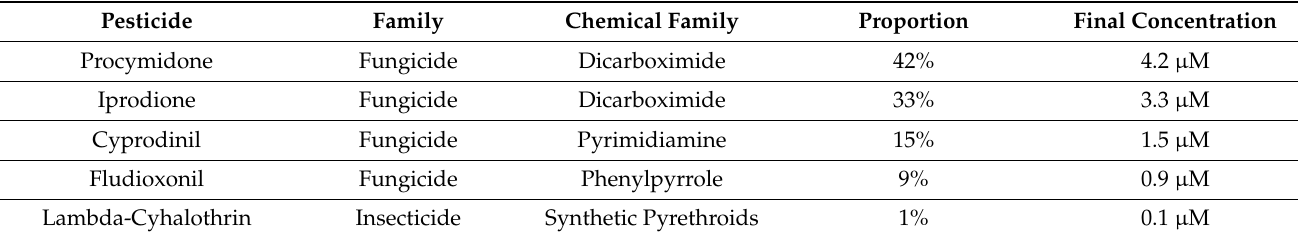
Table 1. Composition of mixture of